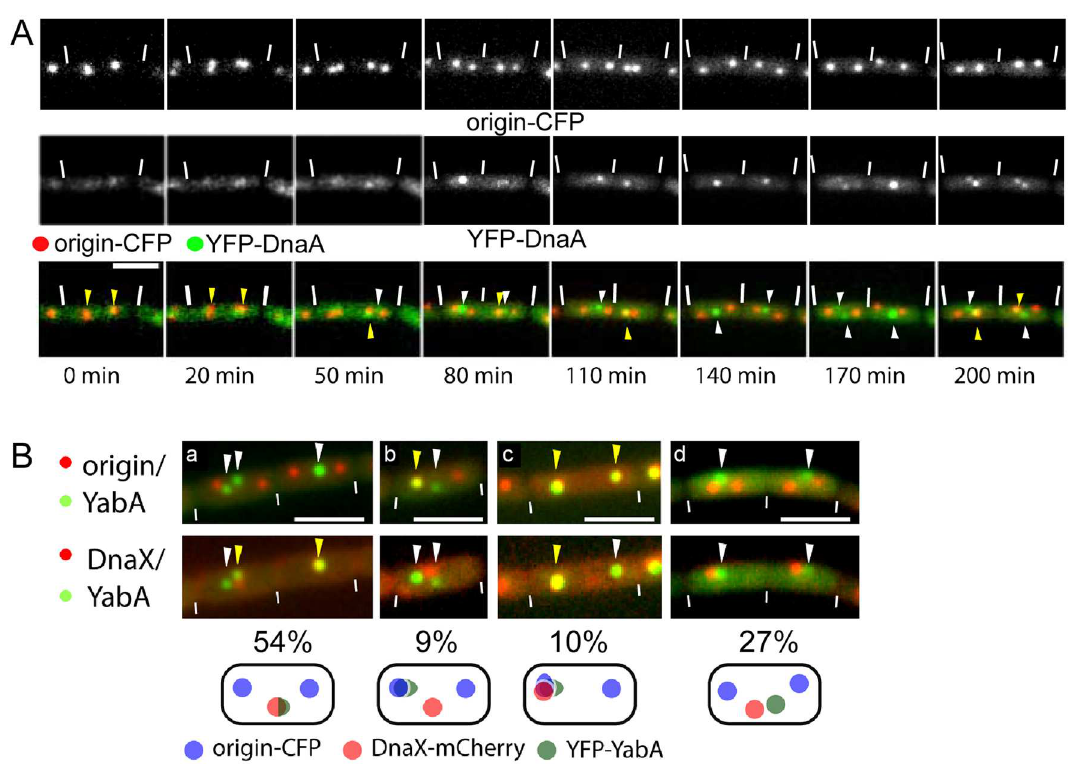
Fig 1. A) Time lapse of YFP-DnaA (strain ME15) localization with respect to the positionof the origin of replication.Upper panel: CFP channelshowingthe positionof origin regions marked by LacI-CFP (note that in the first frame, the signalsmost likely correspond to non-segregated origin regions), middle panel: localization of YFP-DnaA, lower panel: overlayof YFP-DnaA signals(green) with the origin of replication (red) over a time course of 200 min. Triangles indicate the position of YFP-DnaA signals, with yellow trianglesindicatingco-localization and white trianglesno co-localization of both signals. White lines, cell borders; scale bar, 2 μ m. Cells were grown in S750 minimalmedium at 30˚C until early exponential phase. Then the expressionof YFP-DnaA was inducedwith 0.1% xylose (w/v) 15 min. B) Fluorescence microscopyshowing YFP-YabA localizationpatterns in exponentially growing B . subtilis cells. Overlays of YFP-YabA signals (green)with origin- CFP (red) in the upper panel and with DnaX-mCherry (red) in the lower panel.Trianglesindicatepositionsof YFP-YabA foci: white trianglesno co-localization with origin or replicationmachinery, yellow trianglesco-localization. White lines, cell borders; scale bars, 2 μ m. Numbers represent percentage of observedpattern in a sample of 208 cells (note that panel d also includes10% of cells in which one or two of the three signals was not visible). Cartoonsbelowimage panelsillustrate the four different localization pattern